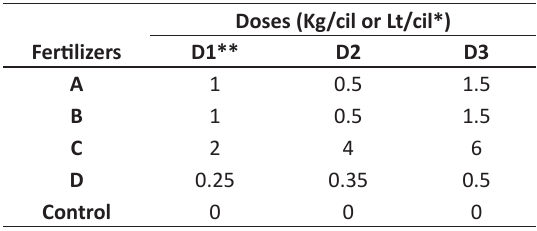
Table 2. Fertilizers and their respective doses in the UNALM – La Molina. Lima-Perú, November